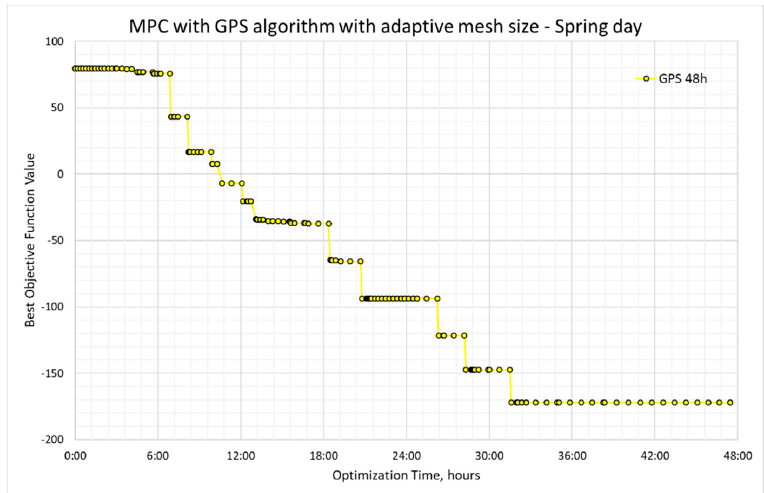
Figure 12. GPS optimization results on the spring day with its adaptive mesh size.